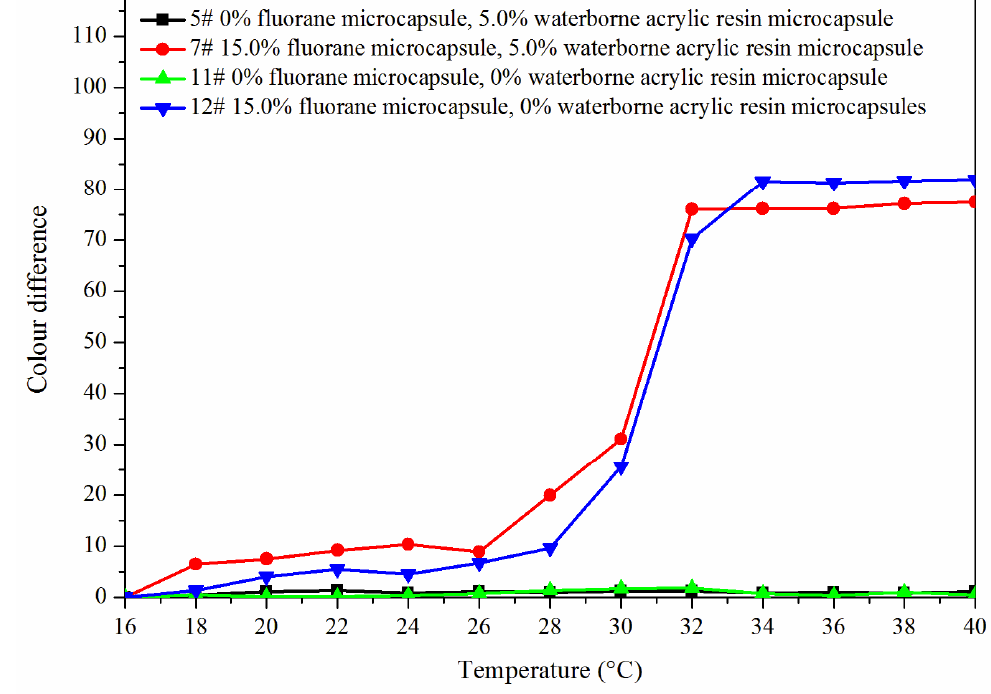
Figure 8. The color difference of the coating with the increased temperature.